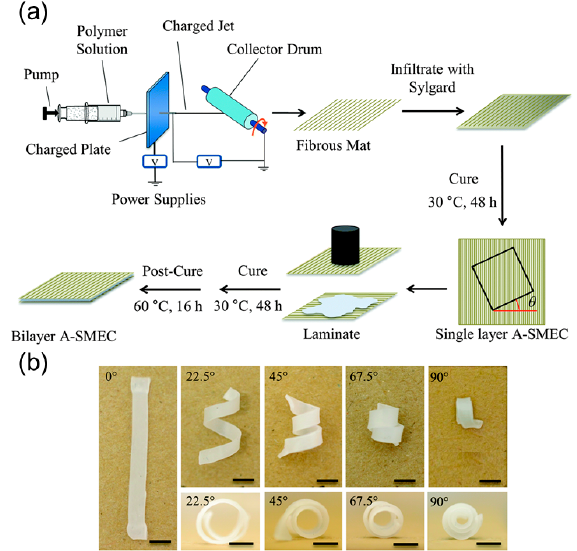
Figure 10. Shape memory polymers-based helical structures mimicking Bauhinia variegata . ( a ) Schematic illustration of the fabrication process of the shape memory elastomeric composite; ( b ) Experimental images of the coiled bilayer composites after heat treatment. The left-top corner of each image shows the tilting angel and the scale bar is 4mm. ( a , b ) are from [44], reprinted with permission from The Royal Society of Chemistry.